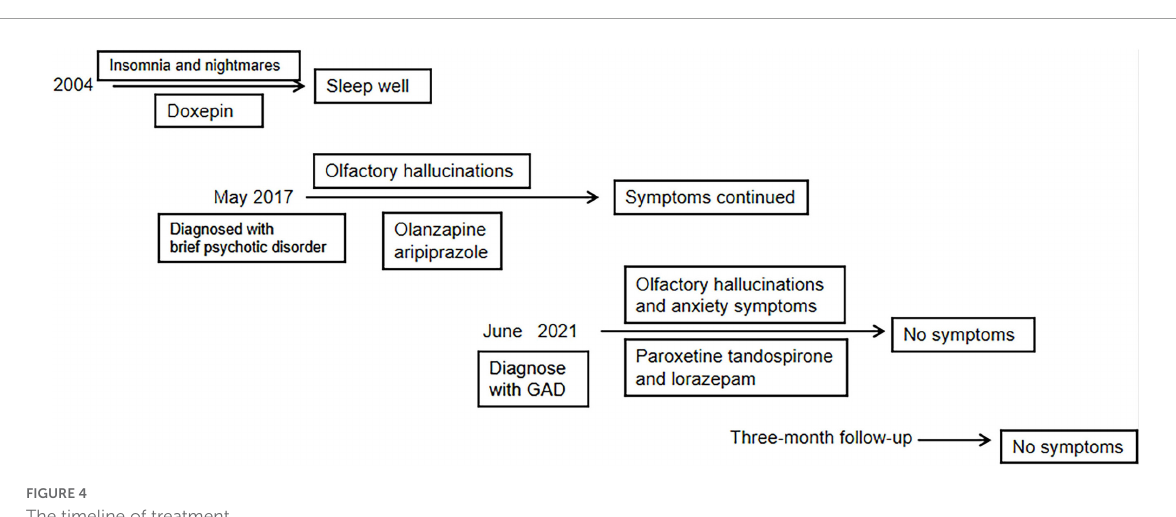
FIGURE4 The timeline of